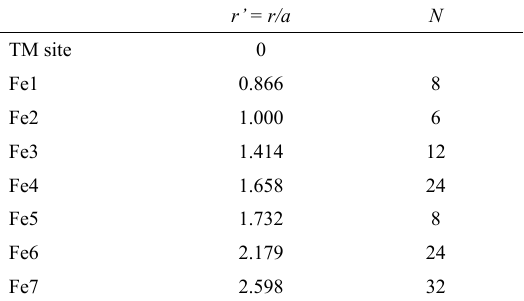
Figure 1. Lattice structure of the 3x3x3 supercell. Table 1. Relative distance r’ = r/a (normalized by the lattice constant a ) from TM impurity to non-equivalente iron sites in the 3x3x3 supercell structure. N stand for the number of all atoms in corresponding neighbors shell (distance r’